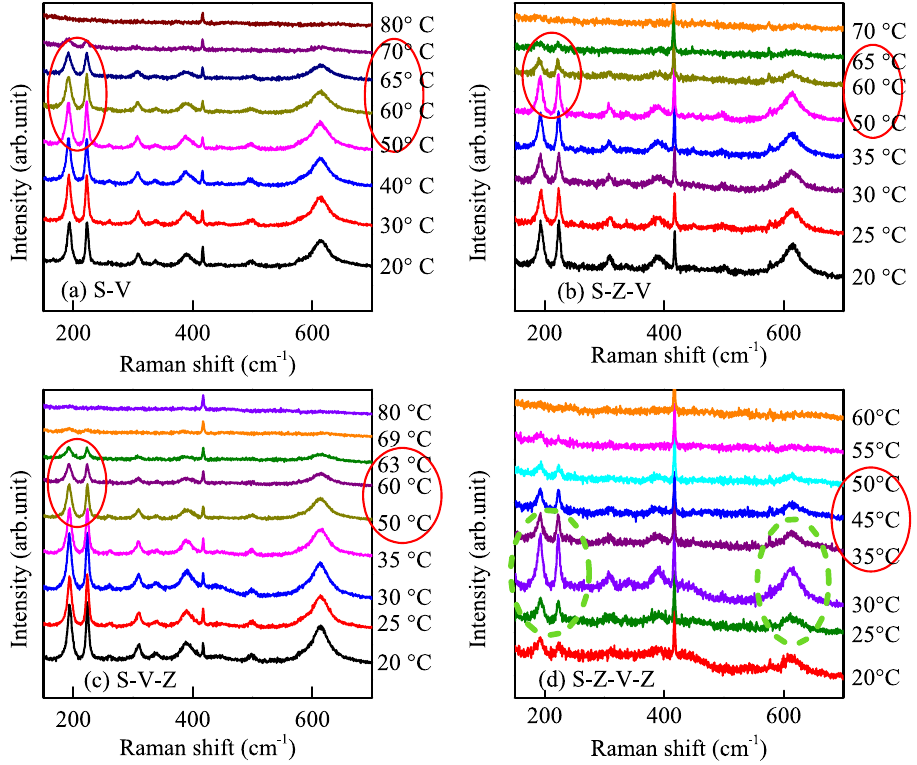
Figure 5. ( a – d ) The temperature-dependent Raman spectra for the four structures from 20 to 90 °C. The red solid and green dashed circles was used to display the transition process and the abnormal variation of Raman